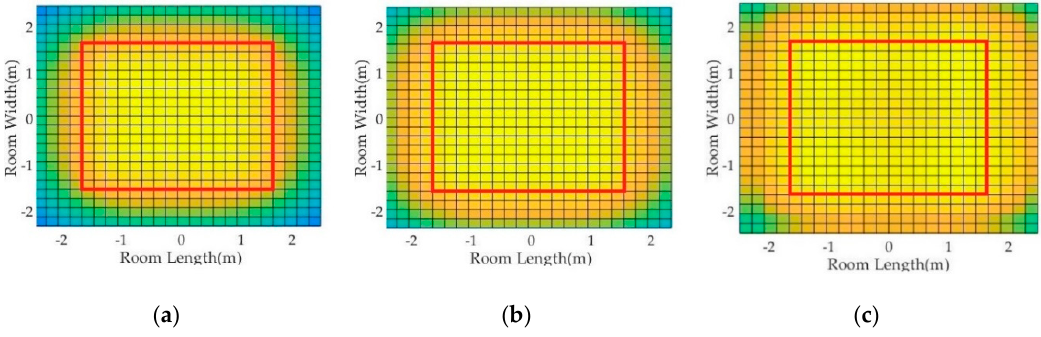
Figure 9. Received optical power with different reflection rates by ( a ) 0.2, ( b ) 0.5, and ( c ) 0.8.